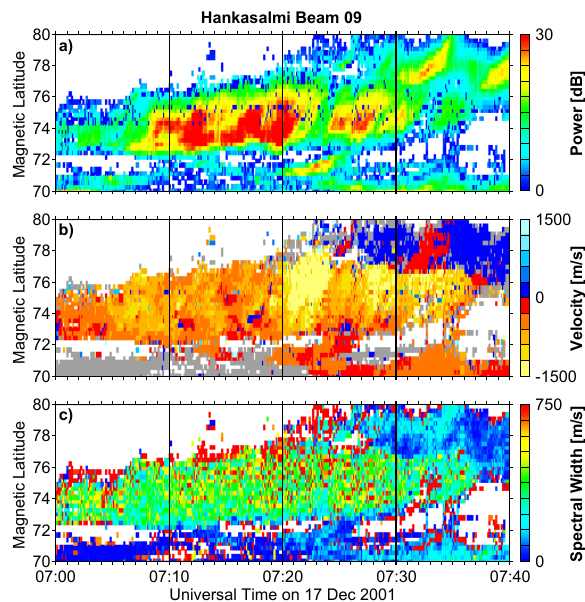
Fig. 5. Same as Fig. 4e–g, except that in panel c the spectral width scale has been increased from 0–300m/s to 0–750m/s to emphasize structures attributed to large flow shears associated with magnetic reconnection events that trigger the onset of a patch injection from corotation to passage through the cusp with the transpolar cap